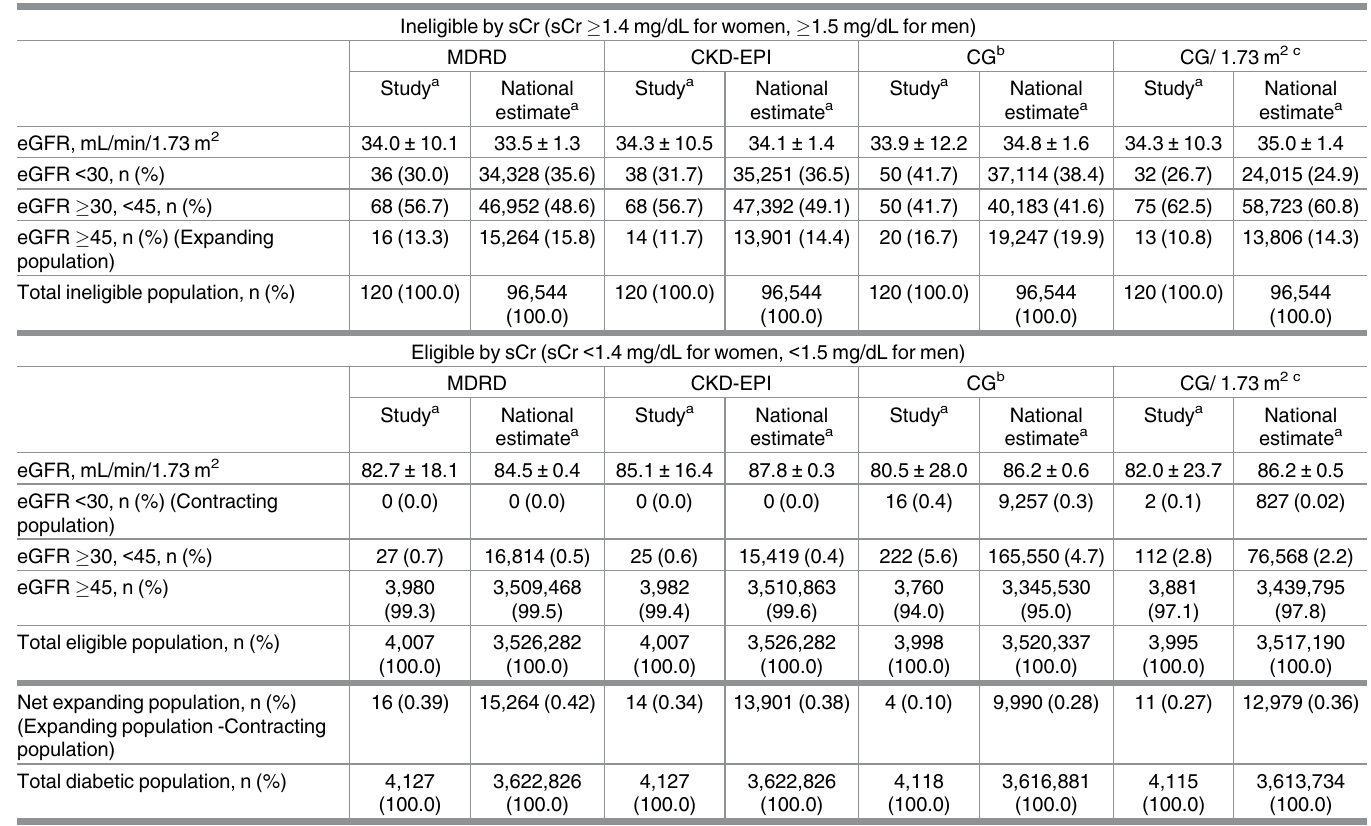
Table 2. eGFR categories of ineligible and eligible population by the sCr level,